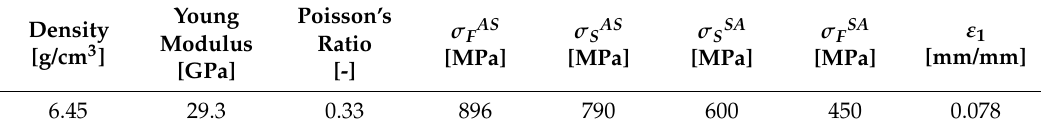
Table 1. Mechanical properties of the shape memory alloy adopted for the wires.